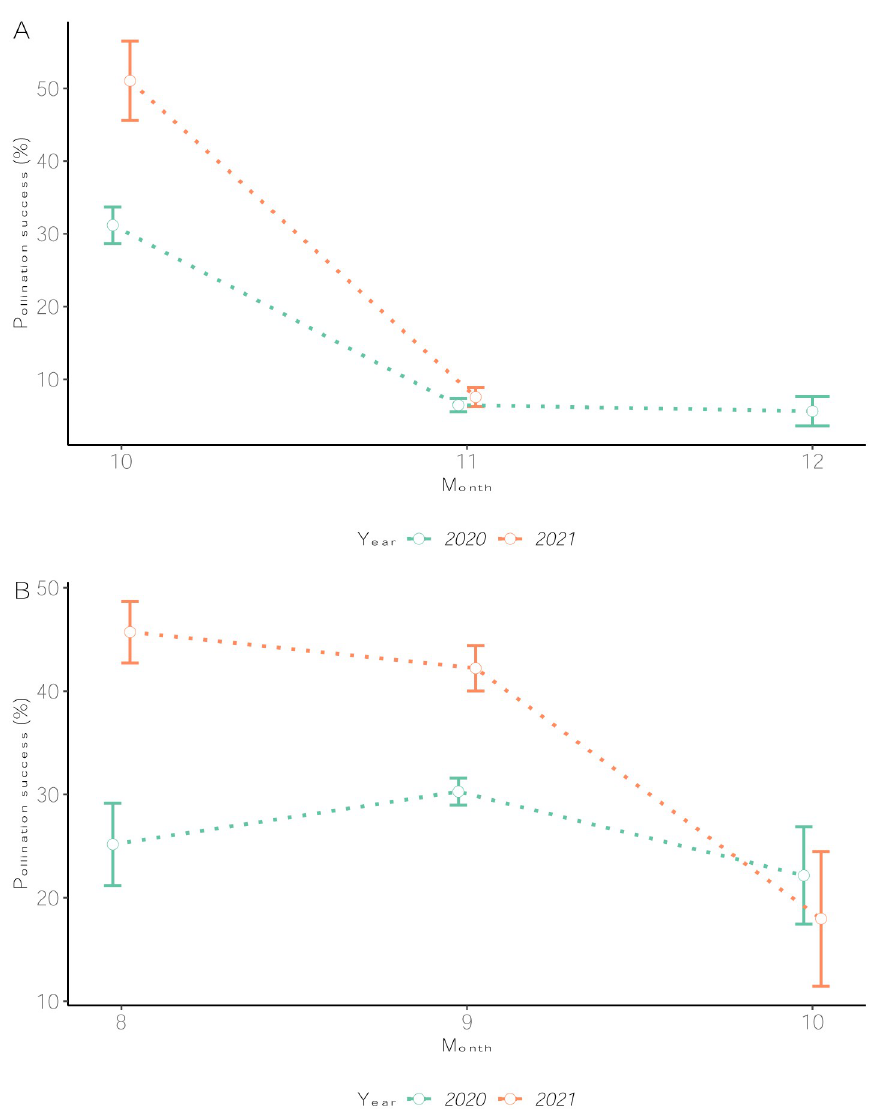
Fig 5. Pollination success rates across crossing months for 2020 and 2021. (A) D . alata and (B) D . rotundata . The number 8 refers to August and 12 to December.